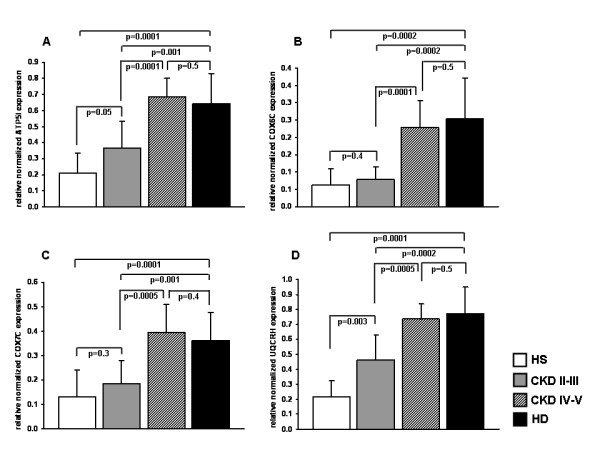
ATP5I, COX6C, COX7C and UQCRH gene expression by RT-PCR in peripheral blood mononuclear cells (PBMC) from healthy subjects (HS), chronic kidney disease (CKD II–III and CKD IV–V) and hemodialysis (HD) patients. The histograms represent the mean ± SD of ATP5I (A), COX6C (B), COX7C (C) and UQCRH (D) level of expression, determined by RT-PCR, in PBMC from 8 HS, 9 CKD II–III, 10 CKD IV–V and 30 HD patients. For all 4 genes, the expression level was significantly higher in HD and CKD IV–V compared to CKD II–III and HS.